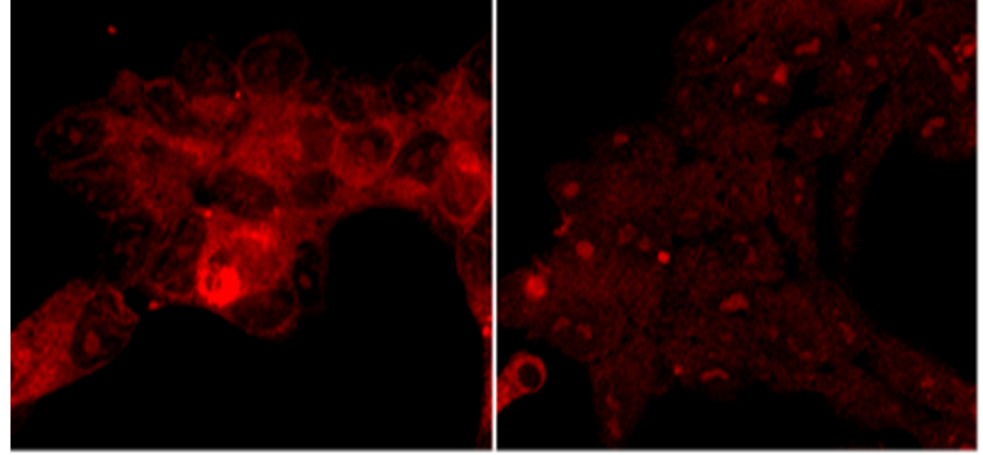
Figure 7. The localization of the compound 35 –Sulfo-Cy5-azide conjugate in 22RV1 cells (( left ) stained by click reaction product; ( right ) Sulfo-Cy5-azide only).